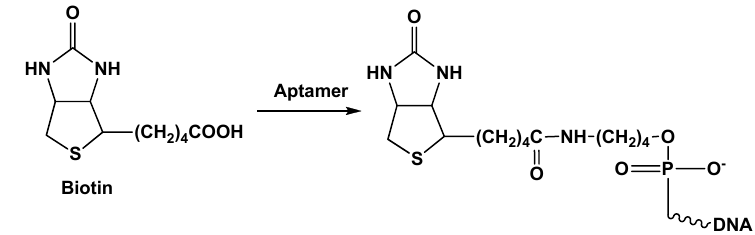
Figure 8. Modification of aptamer with biotin.